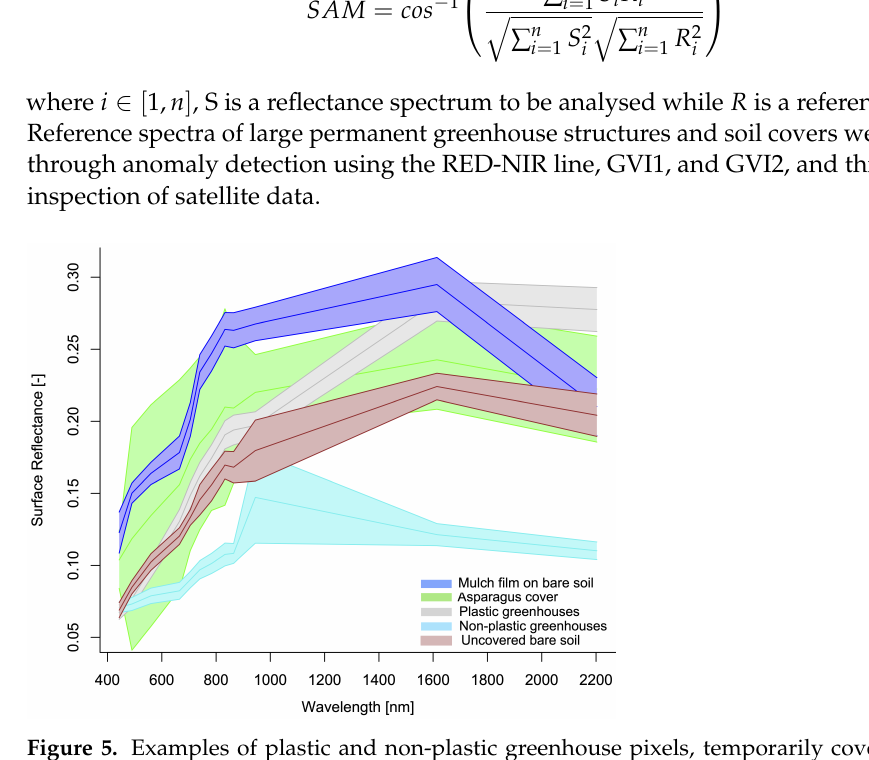
Figure 5. Examples of plastic and non-plastic greenhouse pixels, temporarily covered soil, and uncovered soil pixels, all satisfying NDVI < 0.3. The spectral plots show the mean and standard deviation per band considering 250 spectra for each group. The spectra were extracted from Sentinel-2 data acquired on 20 April